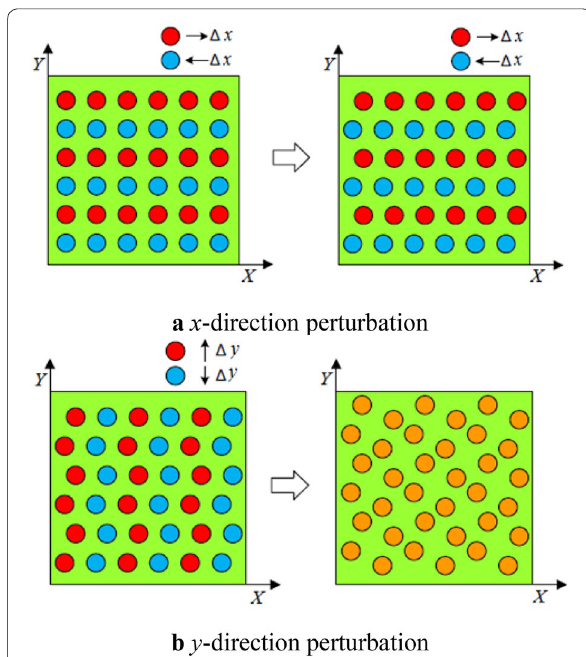
Figure 2 Global perturbation of fiber coordinates